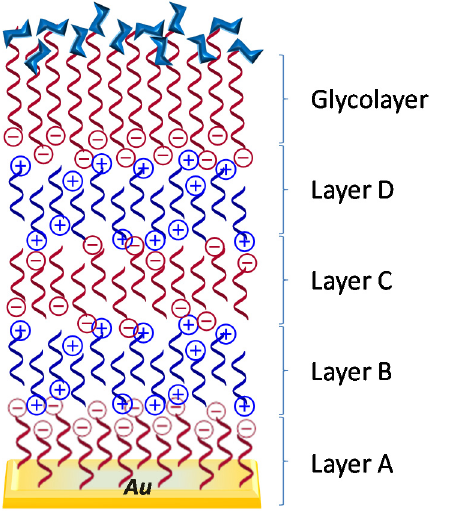
Figure 12. Schematic representation of layer-by-layer preparation of